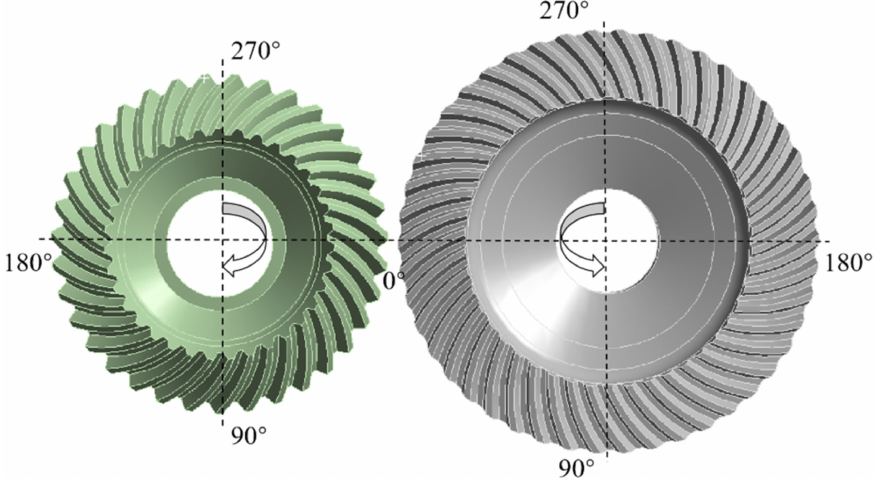
Figure 13. Azimuth angle of